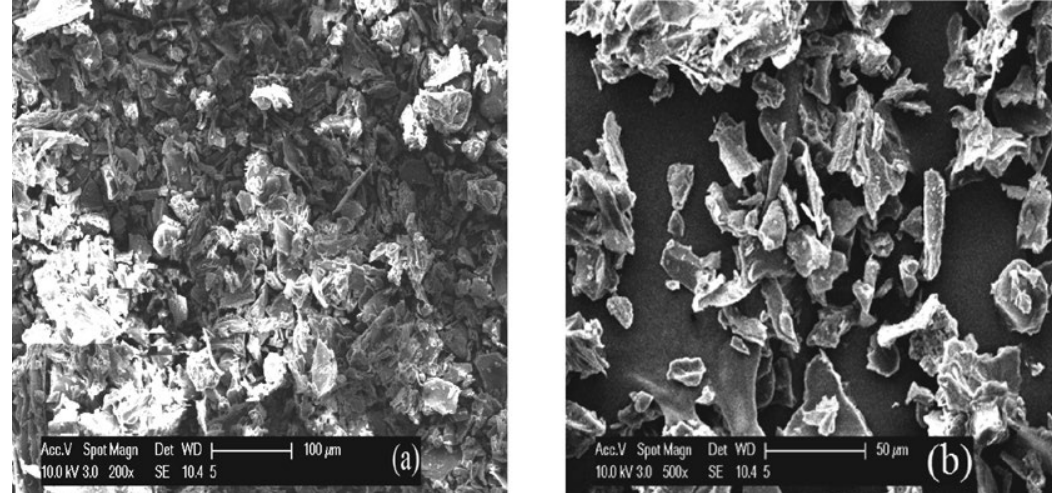
Figure 2. SEM micrographs of PBP at (a) 200x and (b) 500x